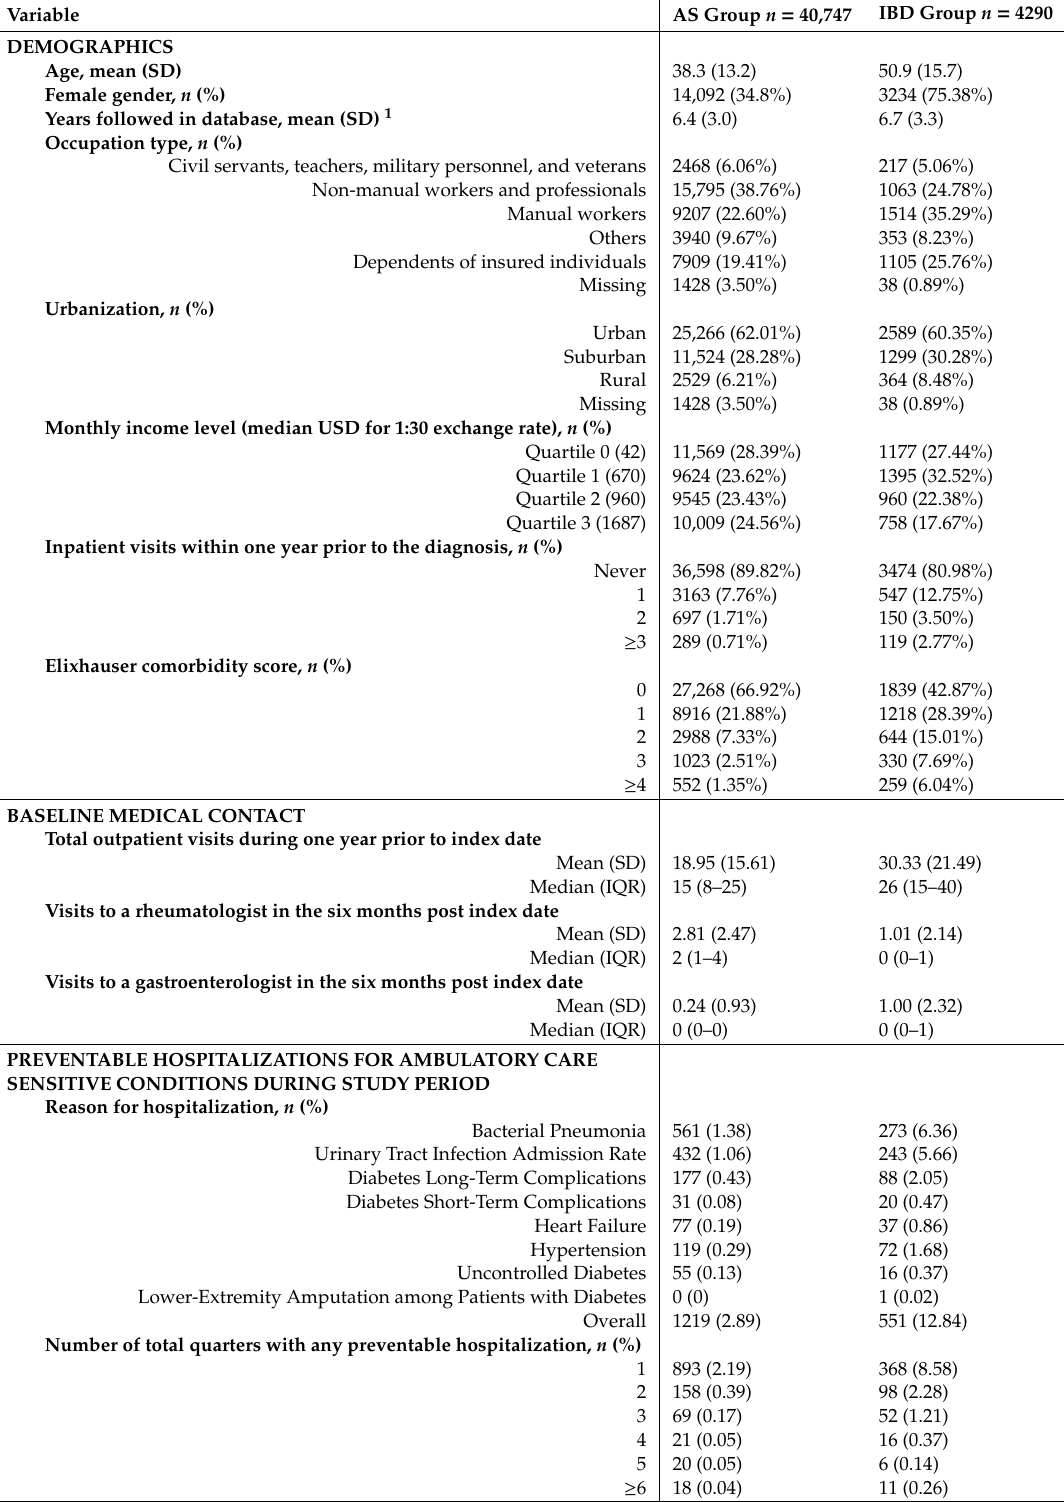
Table 1. Study subject